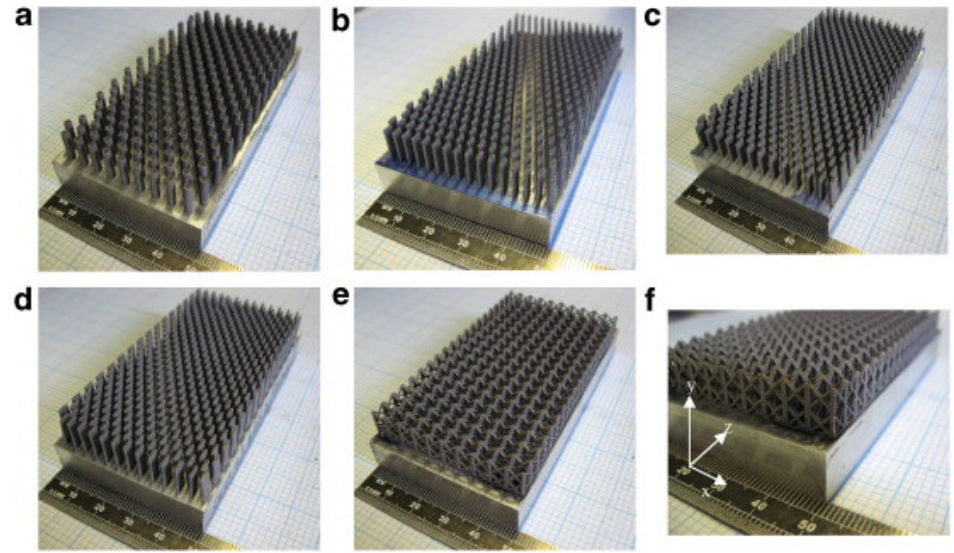
Figure 8. Additively manufactured pin fin heat sinks with different geometries: cylindrical pin ( a ), rectangular fin ( b ), rectangular fins with rounded corners ( c ), staggered elliptical array ( d ) and a lattice structure ( e , f ) Reprinted with permission from Ref. [69]. Copyright 2009 Elsevier.